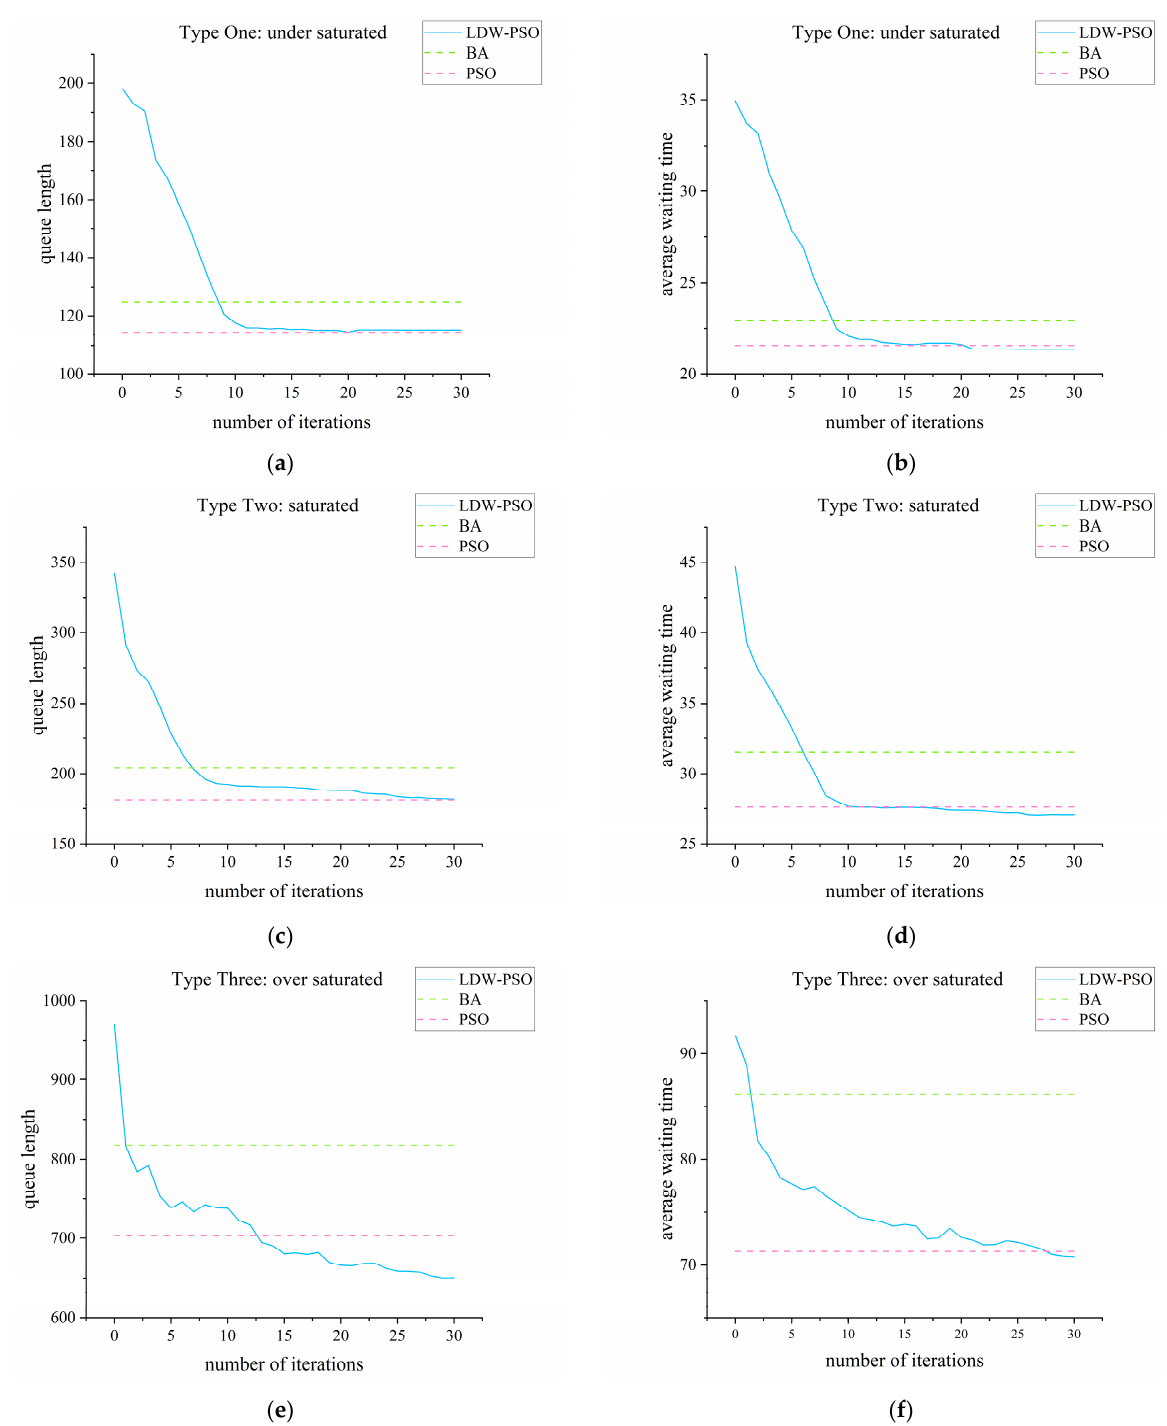
Figure 8. Mean queue length and average waiting time of LDW ‐ PSO solutions each iteration step. The mean values of B.A.’s and standard PSO’s best solutions are represented with dotted lines. ( a ) Type One’s mean queue length; ( b ) Type One’s mean average waiting time; ( c ) Type Two’s mean queue length; ( d ) Type Two’s mean average waiting time; ( e ) Type Three’s mean queue length; ( f ) Type Three’s mean average waiting time. To better show the micro ‐ optimisation, the best optimisation process of LDW ‐ PSO and B.A. for three conditions is shown in Figure 9. The mean values of queue length and